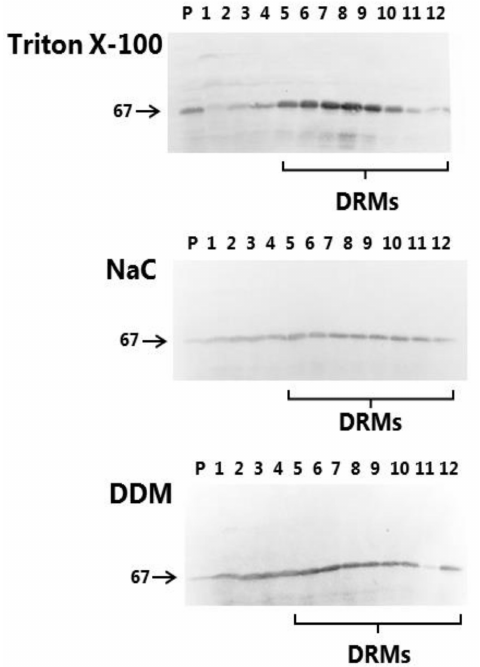
Figure 3. DRM analysis of microvillus membrane vesicles. Microvillus membrane vesicles were prepared and solubilized with either 1% Triton X-100, NaC or DDM on ice, followed by sucrose gradient ultracentrifugation, gradient fractionation, SDS/PAGE and immunoblotting for IAP (67 kDa). “P” indicates the pellet fraction, fractions 1-2 contain solubilized protein and fractions 4–12 contain